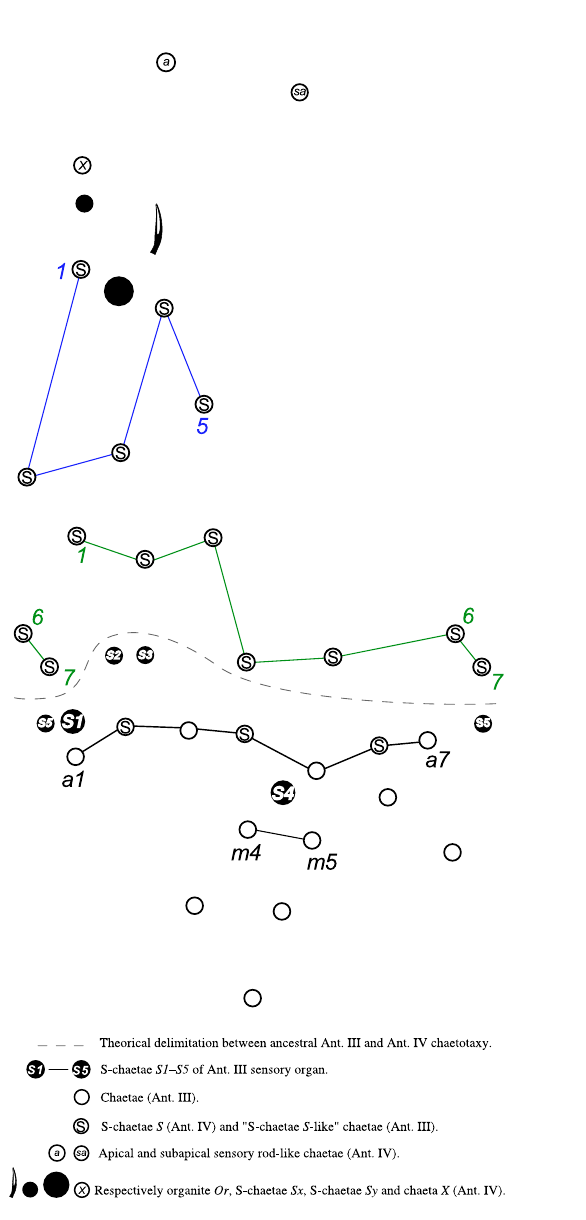
Fig. 8. Spinaethorax adamantis sp. nov., partial diagram of the chaetotaxy of the antenna (Ant. III/Ant.